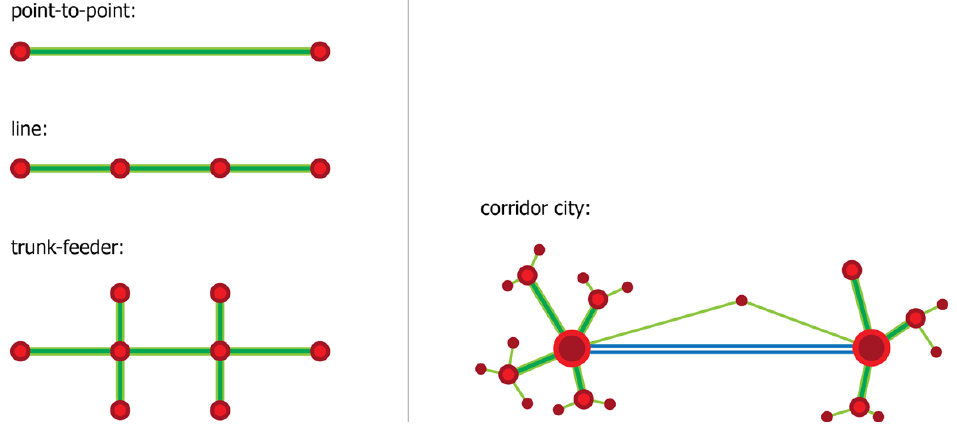
Figure 3. Left : corridor morphologies in terms of network types (after [19]; Right : corridor city with connecting surface infrastructure (after [42]).